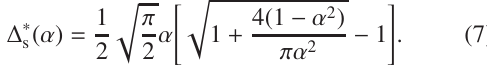
ζ U (d) versus the coe ffi cient | |